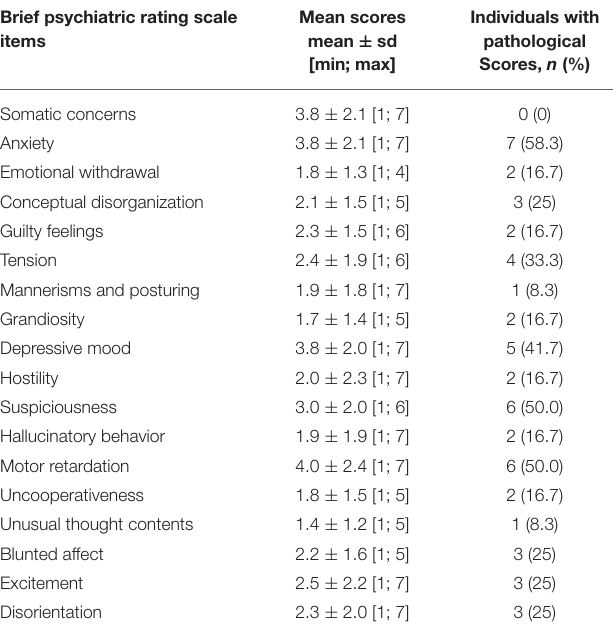
TABLE 3 | Psychiatric characterization of the cohort using the brief psychiatric rating